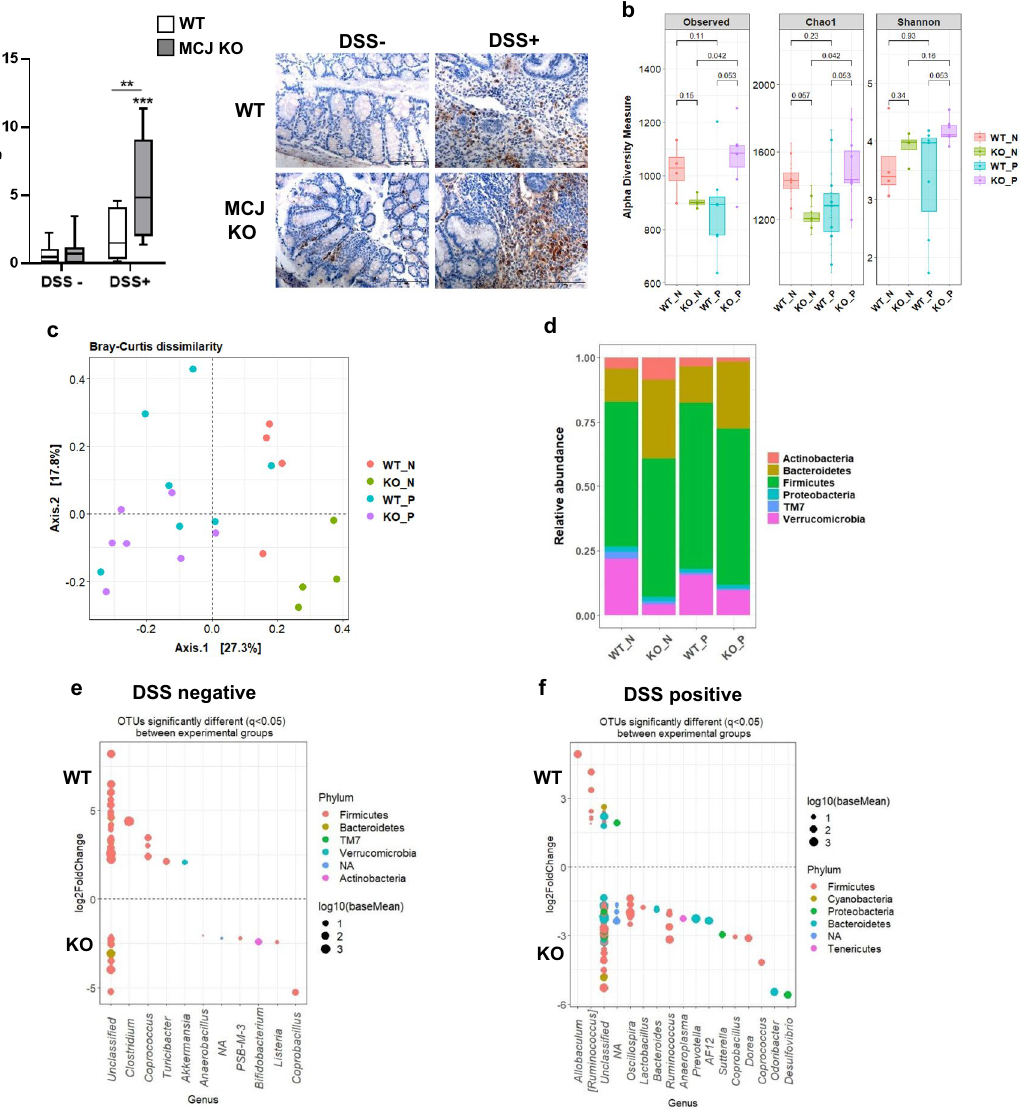
Figure 4. Composition of host microbiome after chronic-induced colitis. ( a ) Quantification and representative images of IgA levels in colon tissue by immunohistochemistry (× 400, scale bar = 100 μm). Box and whisker plots of median, quartiles and range, n = 8 mice per group at a minimum. For statistical analysis two-way ANOVA was used as applicable, * P < 0.05, ** P < 0.01, *** P < 0.001, **** P < 0.0001. “*” above boxes versus control genotype (DSS- versus DSS +), “*” above line versus different genotypes in the same experimental group. ( b ) Alpha diversity (total observed taxonomic units, Chao1 and Shannon diversity indices) in mice fecal microbiota. The non-parametric Wilcoxon rank sum test was used for the statistical analysis. ( c ) Principal Coordinates Analysis (PCoA) plot of bacterial beta-diversity based on Bray–Curtis dissimilarities. ( d ) Stacked bar plots showing the average relative abundance of bacterial phyla in the different experimental groups. Representation of OTUs that significantly (q < 0.05) differ in colon content at genus level between ( e ) WT and MCJ-deficient controls and ( f ) WT and MCJ-deficient chronic colitis groups. Each point represents a single OTU colored by phylum and grouped by taxonomic family, and point´s size reflect the mean abundance of the sequenced